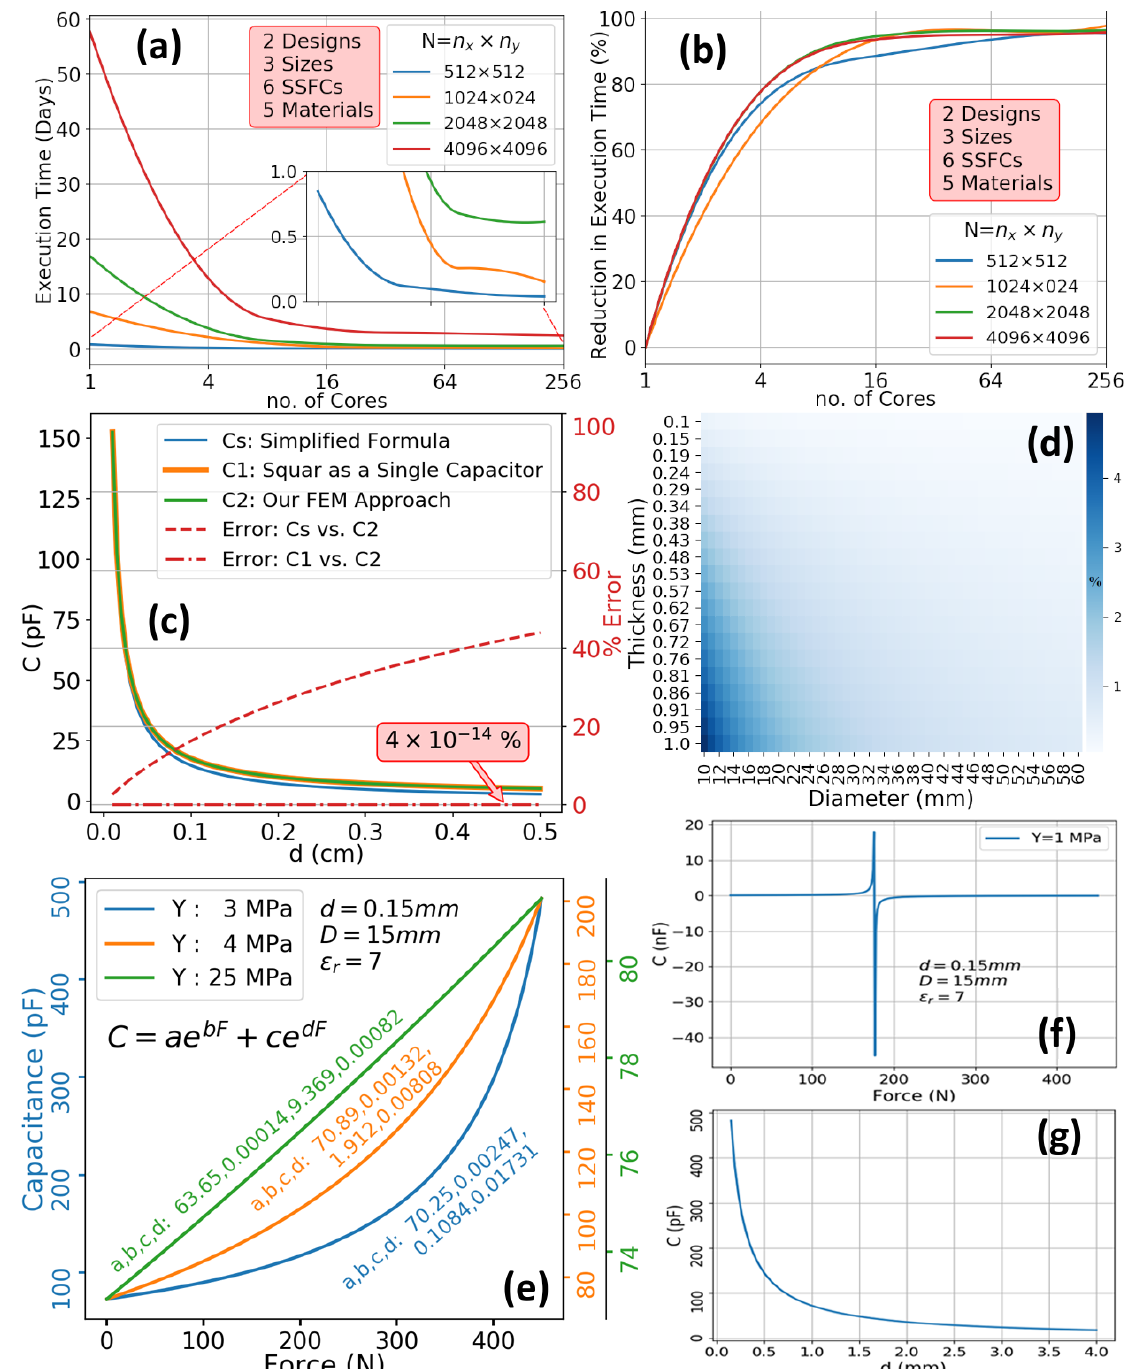
Figure 9. Testing and HPC Simulation Results. ( a ) Execution Time ( b ) Speedup ( c ) Error Comparison ( d ) Error Due to Geometry Change ( e ) Calibration Curves ( f ) Sensing Material Suitability Test ( g ) Capacitance vs. Material